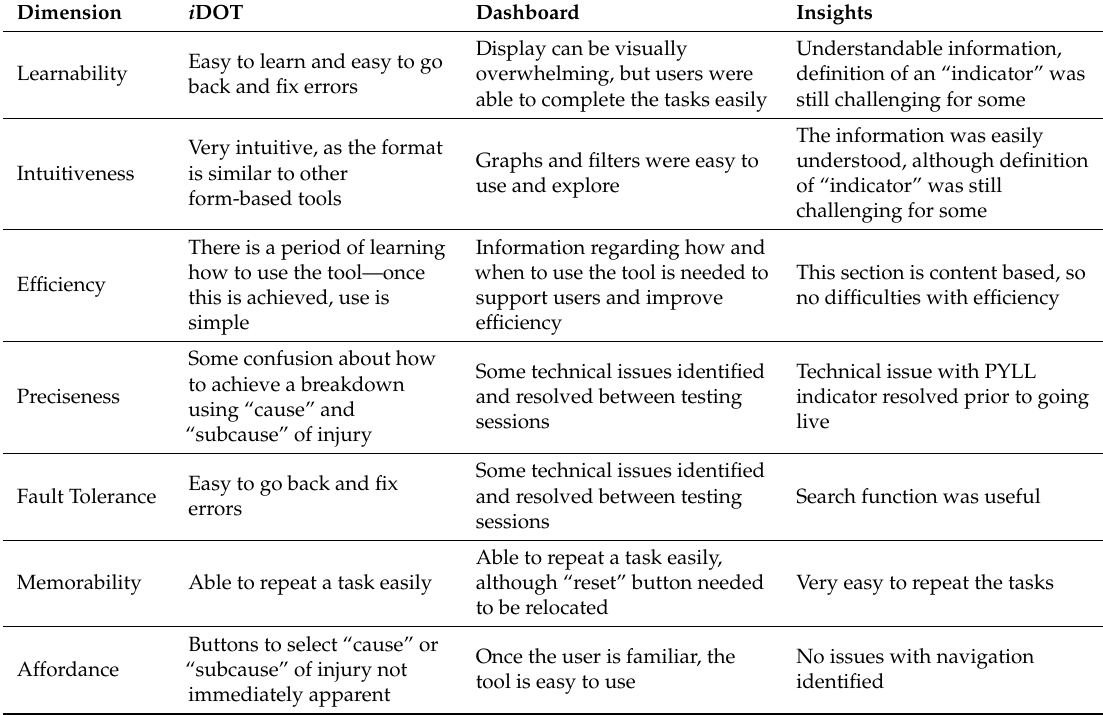
Table 1. Qualitative results of the usability testing